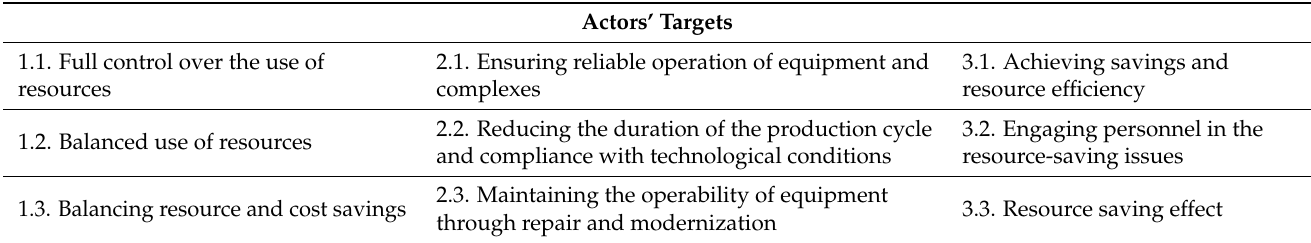
Table 2. Main results obtained at the “Actors’ Targets”